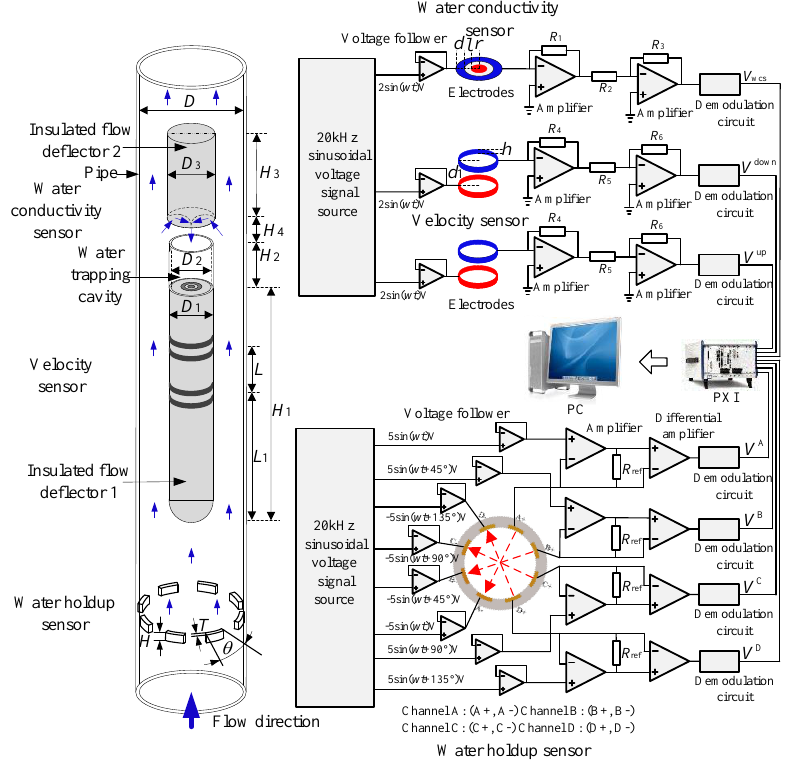
Figure 3. The combined conductance sensor system.